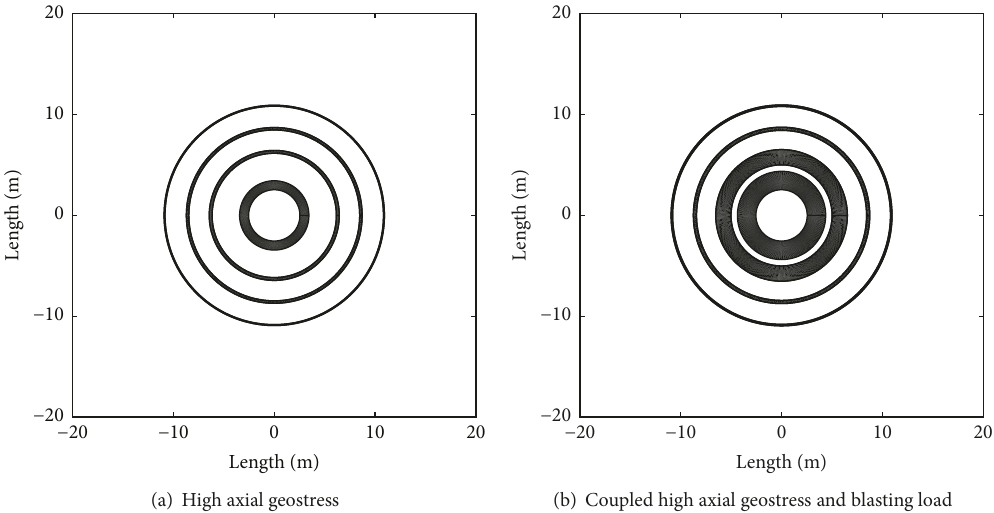
Figure 4: Zonal disintegration from present numerical computation result.